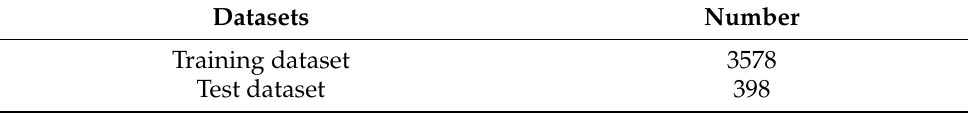
Table 3. The distribution of the training dataset and test dataset of the student achievement